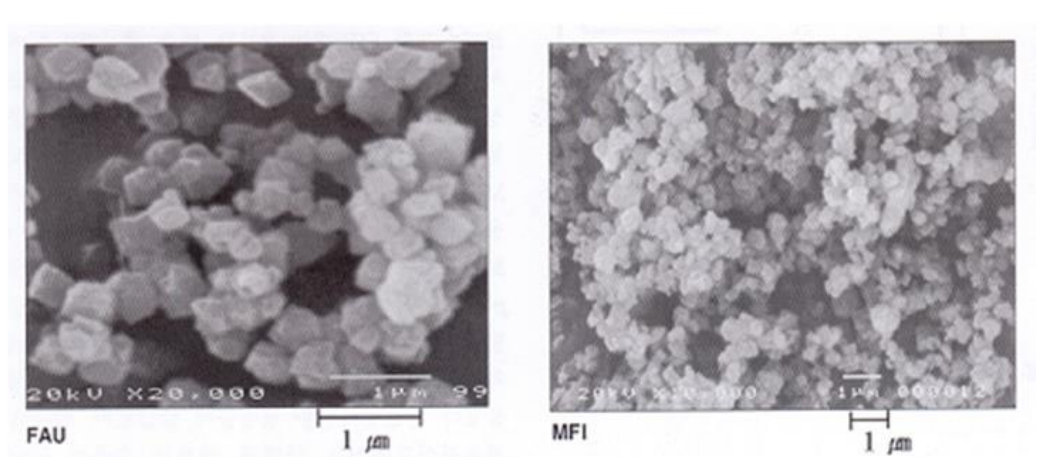
Figure 2. SEM images of the MWW, BEA, MOR, FAU, and MFI zeolites.